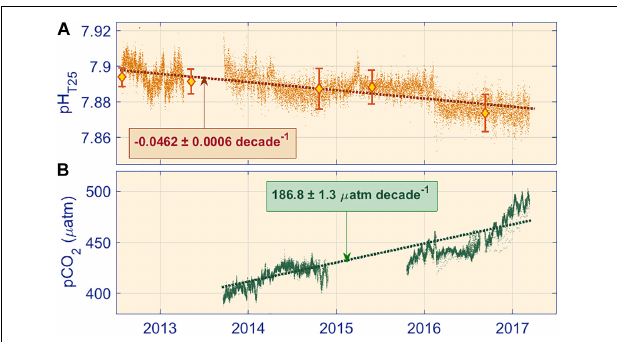
FIGURE 5 | (A) Time evolution of the SAMI-pH data and the estimated linear trend (dashed line) from August 2012 to March 2017. (B) Same as (A) , but for pCO 2 data. Red diamonds and associated bars in panel (A) are the mean and std of the discrete pH T 25 values obtained directly from seawater samples through the spectrophotometric